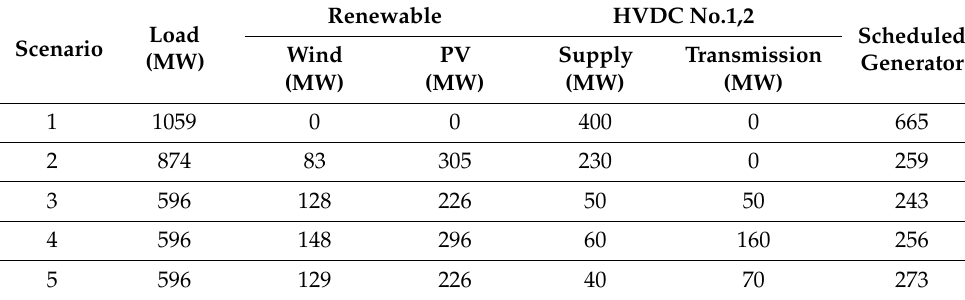
Table 3. Scenario A configuration (HVDC No.3 non-modeling).